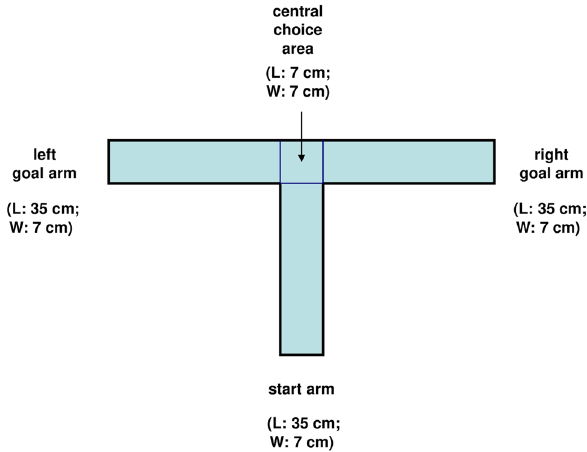
Figure 1. Schematic of the T-maze apparatus. Each arm (start, left and right) is 35 cm long. Central choice area is a 7 cm × 7 cm square. Total width of the maze (from distal end of the left arm to distal end of the right arm) is 77 cm. Total length of the maze (from distal end of the start arm to northern wall) is 42 cm. The blue lines indicate the positions of the three vertically sliding